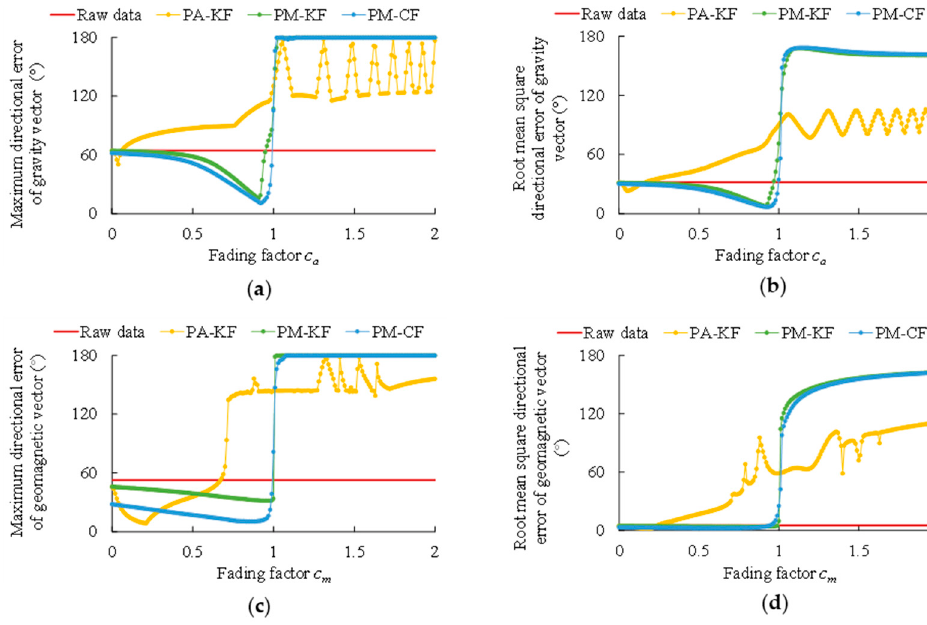
Figure 5. Performance of each algorithm versus fading factors, in terms of the directional errors of gravity vector g and geomagnetic vector h . ( a ) Maximum error of g . ( b ) RMSE of g . ( c ) Maximum error of h . ( d ) RMSE of h .